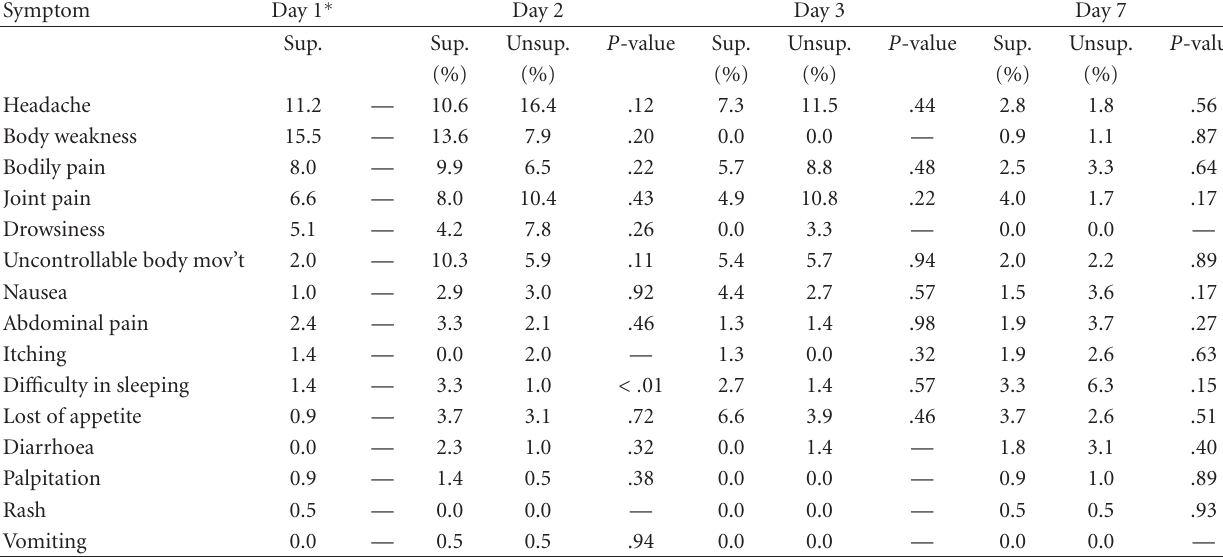
Table 3: Reported side-e ff ects within 7 day post first dose.